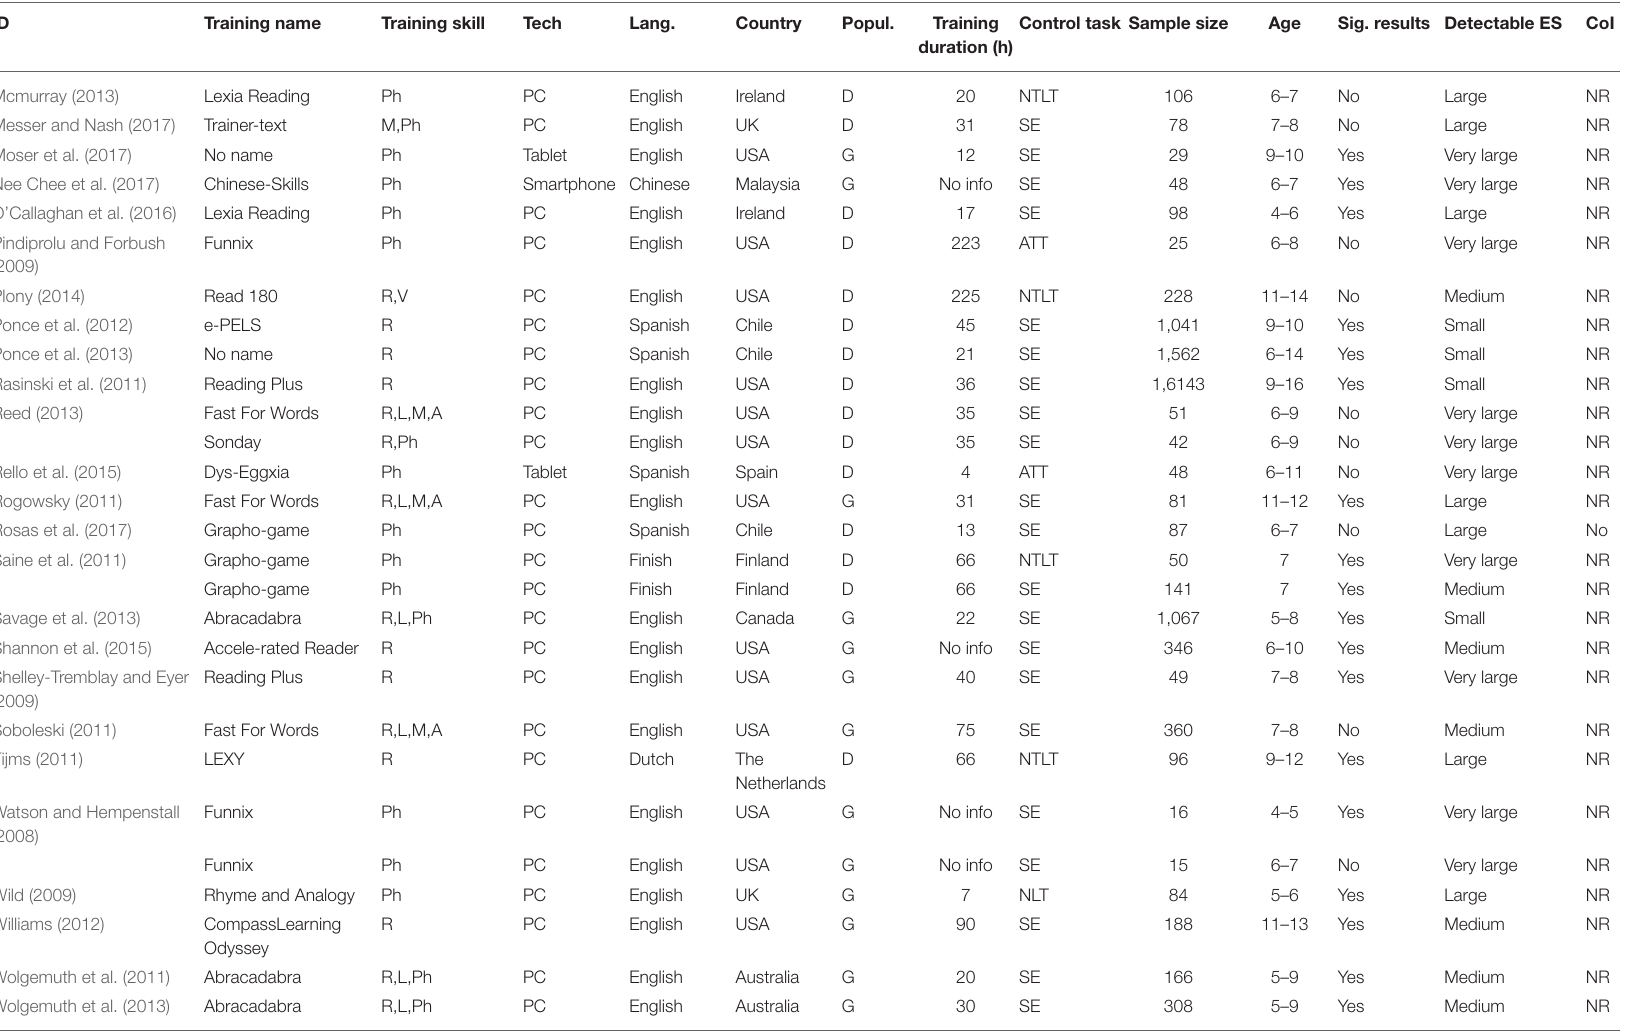
Training Skill: A, attention; L, listening; M, working memory; Ph, phonology; R, reading; V, vocabulary. Population: A, illiterate adults; D, reading disorders or difficulties; G, general population (children). Control task: ATT, another technological training; NLT, non-literacy tasks; NTLT, non-technological literacy task; SE, standard education. Detectable ES: smallest effect-sizes the study could potentially detect assuming a two-sample t-test. CoI, Conflict of interest; NR, Not reported. * Adequately